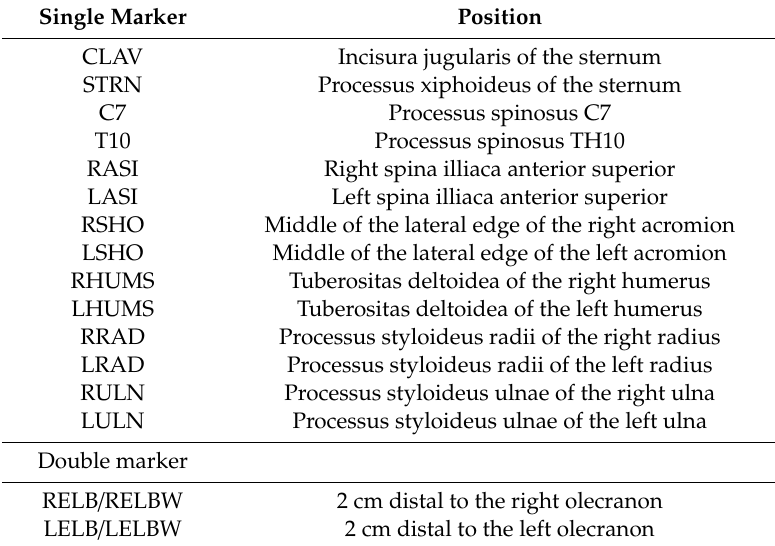
Figure 1. Overview of the measurement setup. A subject performing an exo/endorotation, with simultaneous collection of EMG and kinematics. Table 1. Description of the placement of the markers.